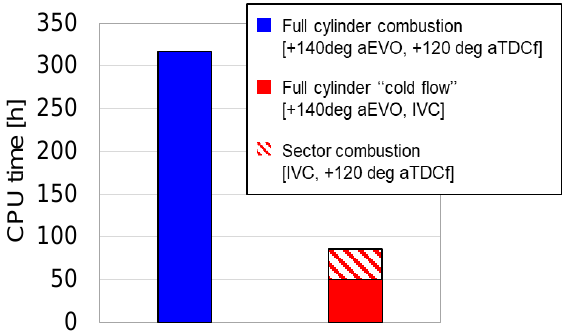
Figure 7. Computational time comparison of the full cylinder (blue) and the sector mesh approaches (red–white), which needs a preliminary full cylinder cold flow analysis (red). The CPU time is referred to simulations distributed on 24 cores, Intel Xeon E5–2680 v3 2.50 GHz processor.